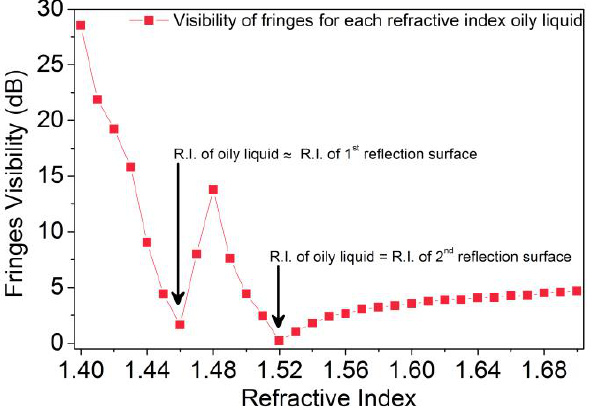
Figure 4. Strength visibility of the fringes versus the refractive index of the oily liquids that were examined.